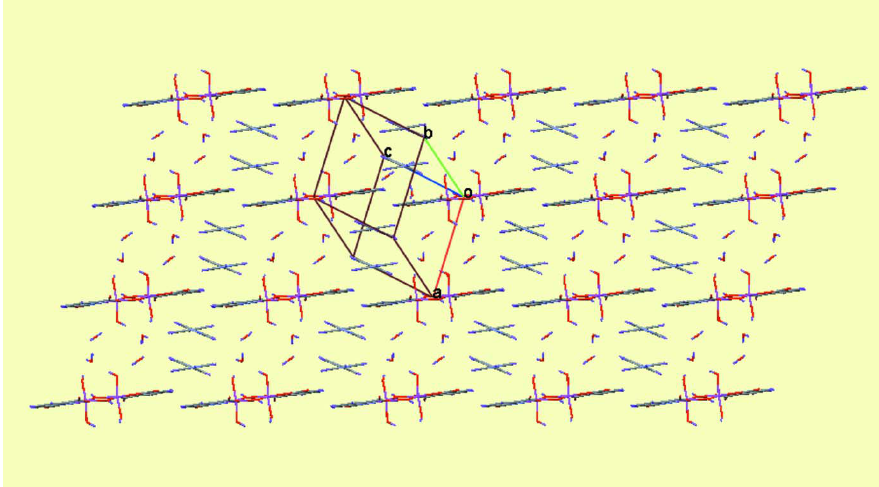
Figure 4 Layered diagram of the title compound. The space between the two layers of {[Sb(pydc)(OH) filled with (4,4′-bipyH) + cations and water molecules.